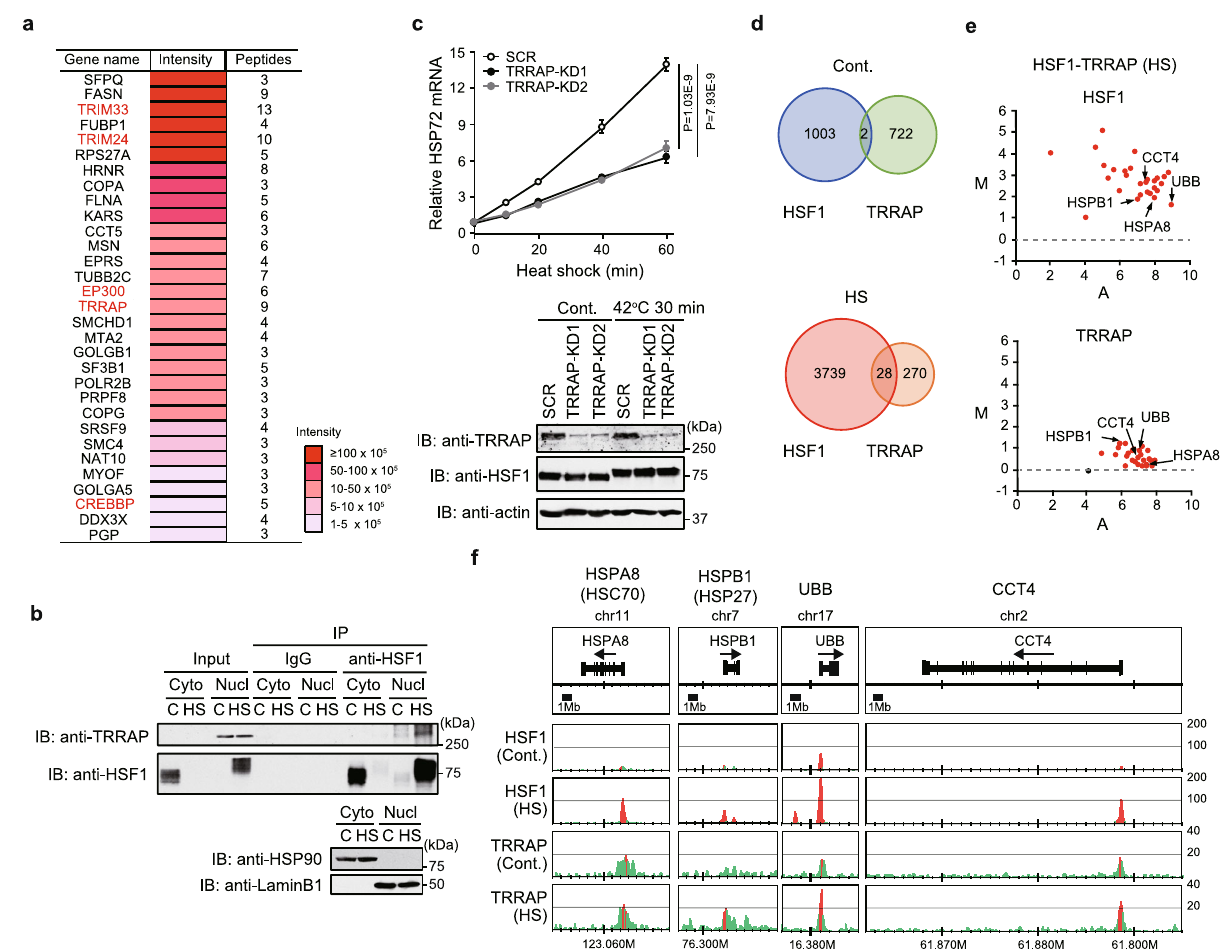
Fig. 1 | Identi fi cation of the co-activator TRRAP that interacts with HSF1. a Relative enrichment of proteins identi fi ed in HSF1 ChIP preparations from heat-shockedcells.HeLacellswereuntreatedortreatedwithheatshockat42°C for 60min, and HSF1-interacting proteins were identi fi ed by ChIP-MS. Thirty- one proteins highly enriched upon HS (difference of peptide numbers >3) are shown. Proteins related to histone modi fi cations are indicated in red. b HSF1 interacts with TRRAP in the nucleus during heat shock. Cytoplasmic (Cyto) and nuclear (Nucl) extracts were prepared and complexes co-immunoprecipitated using anti-IgG or anti-HSF1 and subjected to immunoblotting. c Expression of HSP72 mRNA in TRRAP-KD cells during heat shock. Levels of HSP72 mRNA were quanti fi ed, and the levels relative to that in control SCR-treated cells are shown.